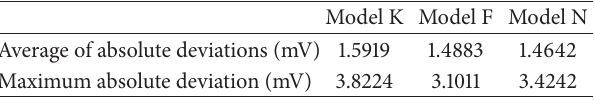
Table4:Valuesoffittingparametersobtainedfromthethreemodels (bench test).